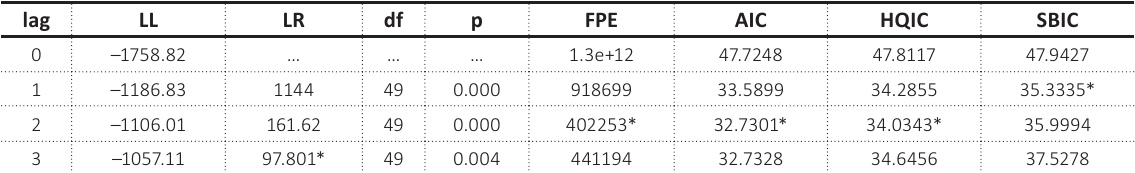
Note: * The criterion value indicates the optimal lag.